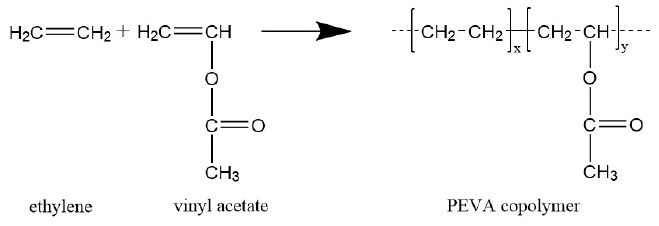
Figure 1. Chemical structure of monomers and poly(ethylene ‐ co ‐ vinyl acetate) random copolymers (PEVA).